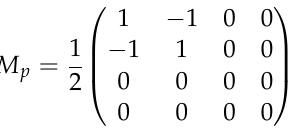
Figure 2. Block diagram showing the concept of phase delay measuring. When the light is incident vertically, the LCVR drive voltage is continuously adjusted and the corresponding light intensity is measured using an optical power meter, and the amount of LCVR phase delay is obtained using Equation (6).